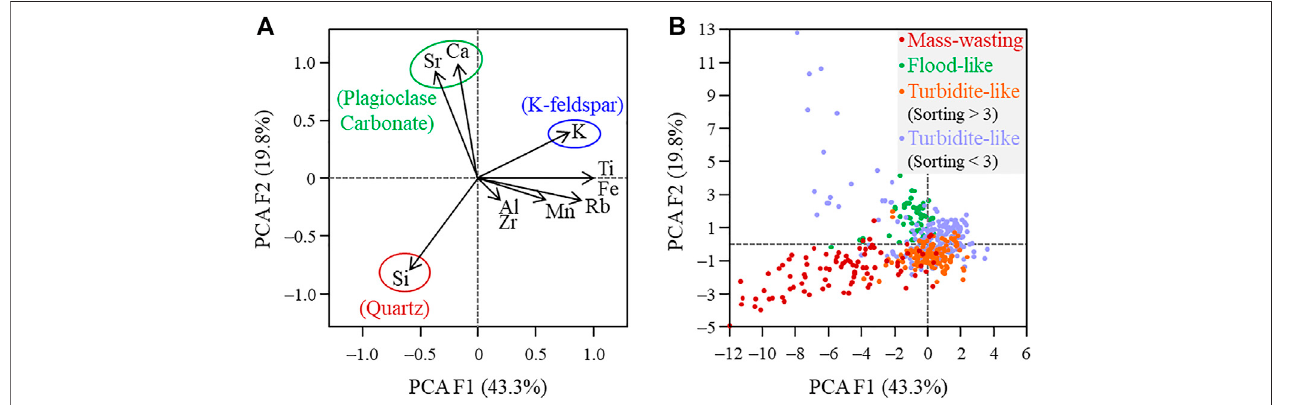
FIGURE 5 | (A) Variables factor map and (B) individuals factor map for principal component analysis (PCA) performed on the standardized elemental data of the Y20B core.